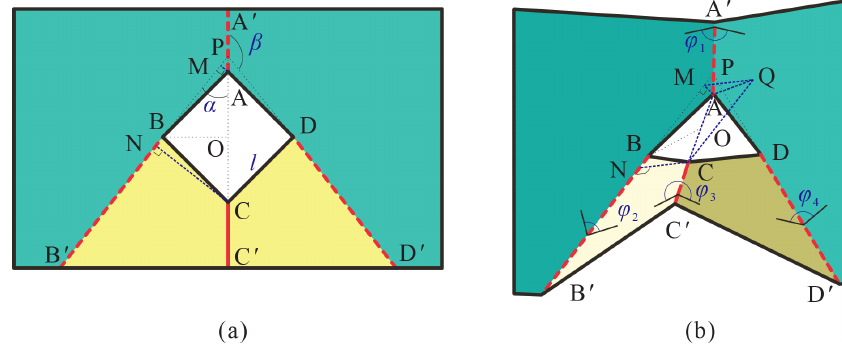
Figure 3. The four-crease pattern (a) at the deployed configuration, and (b) at the folding configuration. √ (cid:20) θ 2 M = − 2 sin( γ + β )sin γ 2 l tan 2